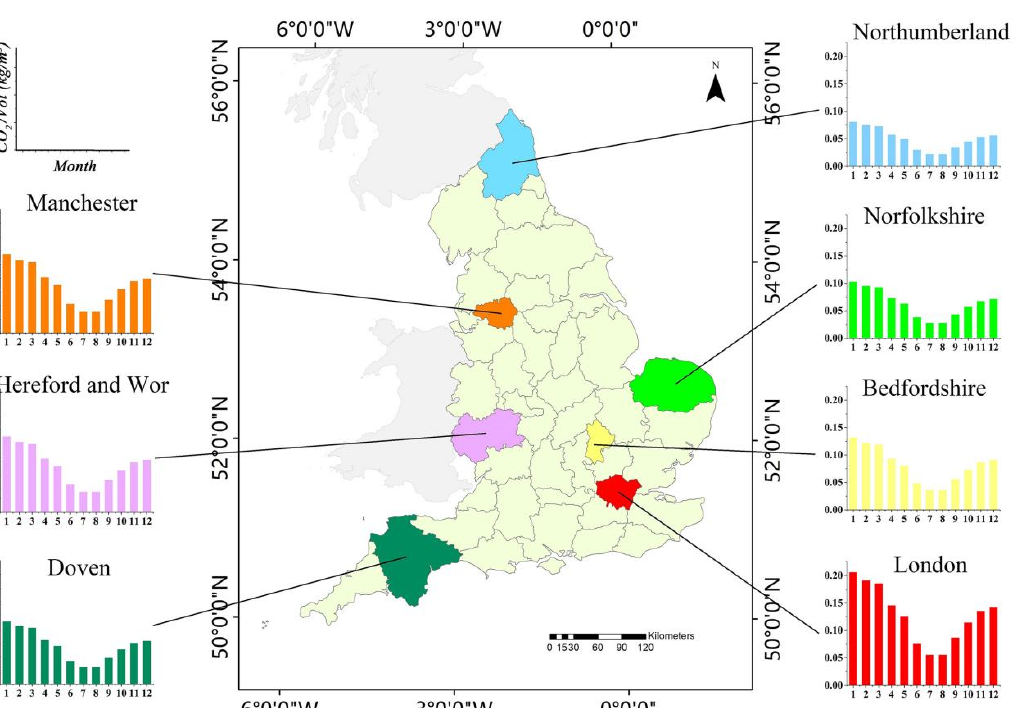
Figure 9. Ratio of CO 2 emissions per volume of seven counties.